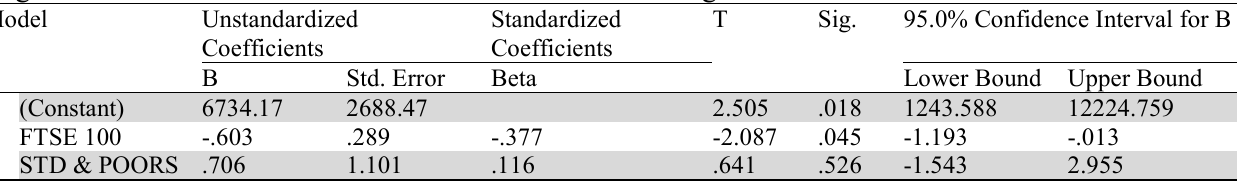
Regression Coefficients on the Influence of Financial Contagion on Performance of NSE 20 Share Index